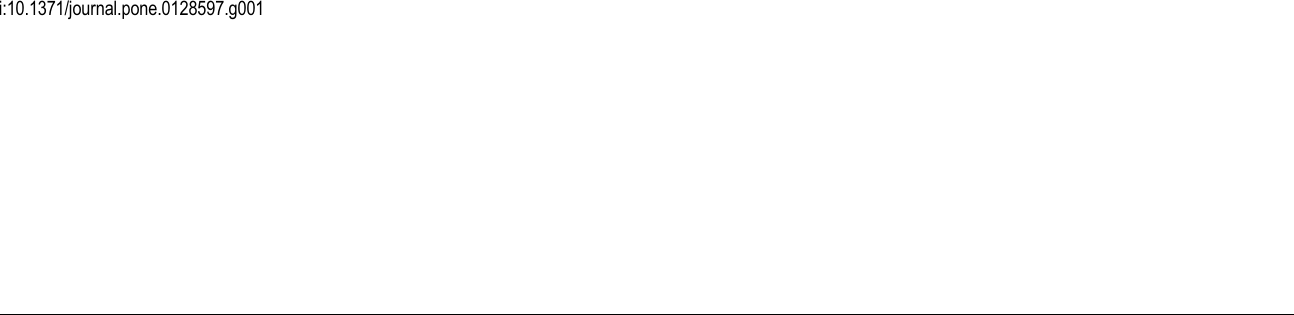
PLOS ONE | DOI:10.1371/journal.pone.0128597 May 22, 2015 3 /